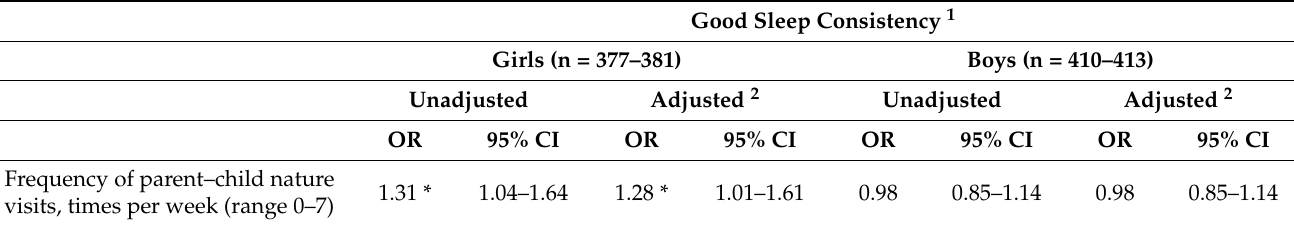
Table 3. Logistic regression analyses of the associations between the frequency of parent–child nature visits per week and children’s good sleep consistency.